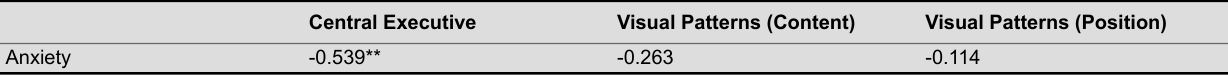
Visual Patterns (Position)Visual Patterns (Content)Central Executive